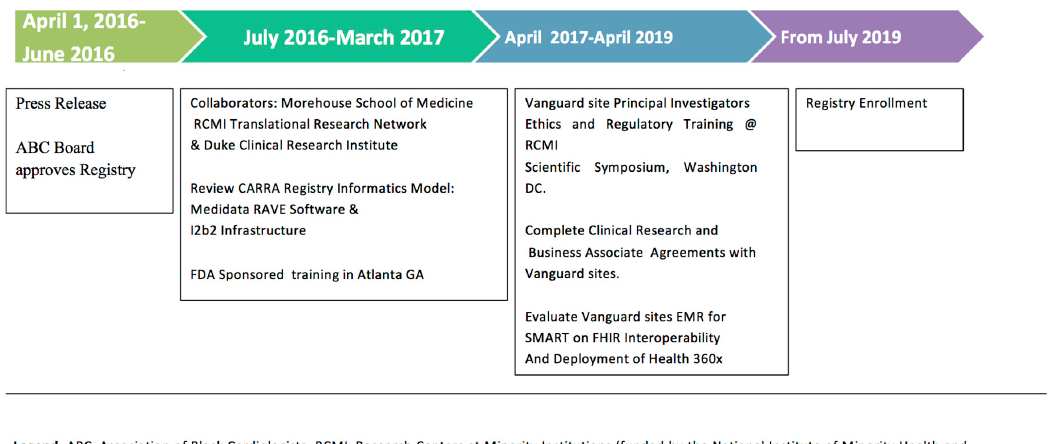
Figure 2. ABC CVIS Registry Timeline.